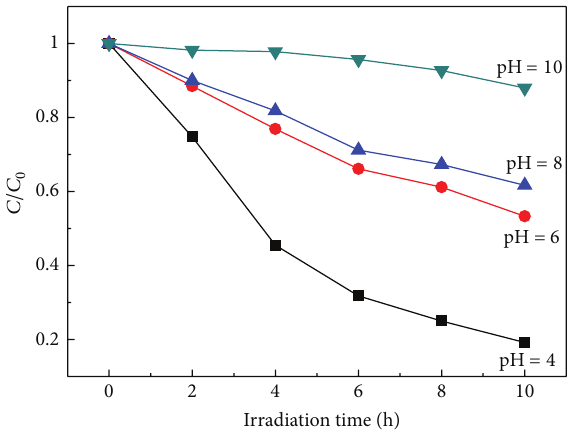
Figure 9: UV-Vis absorption spectra of phenol degradation with 0.25 g N-doped TiO 2 at pH